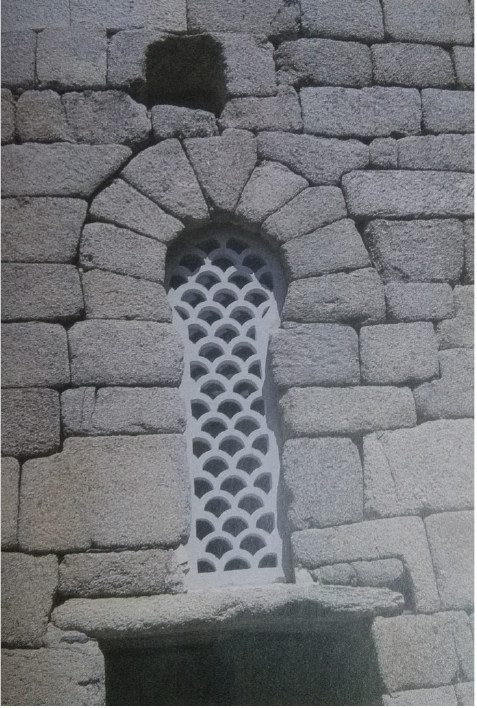
Figure 3. Window of the church of Santa María de Melque 10th century, Toledo (Spain).